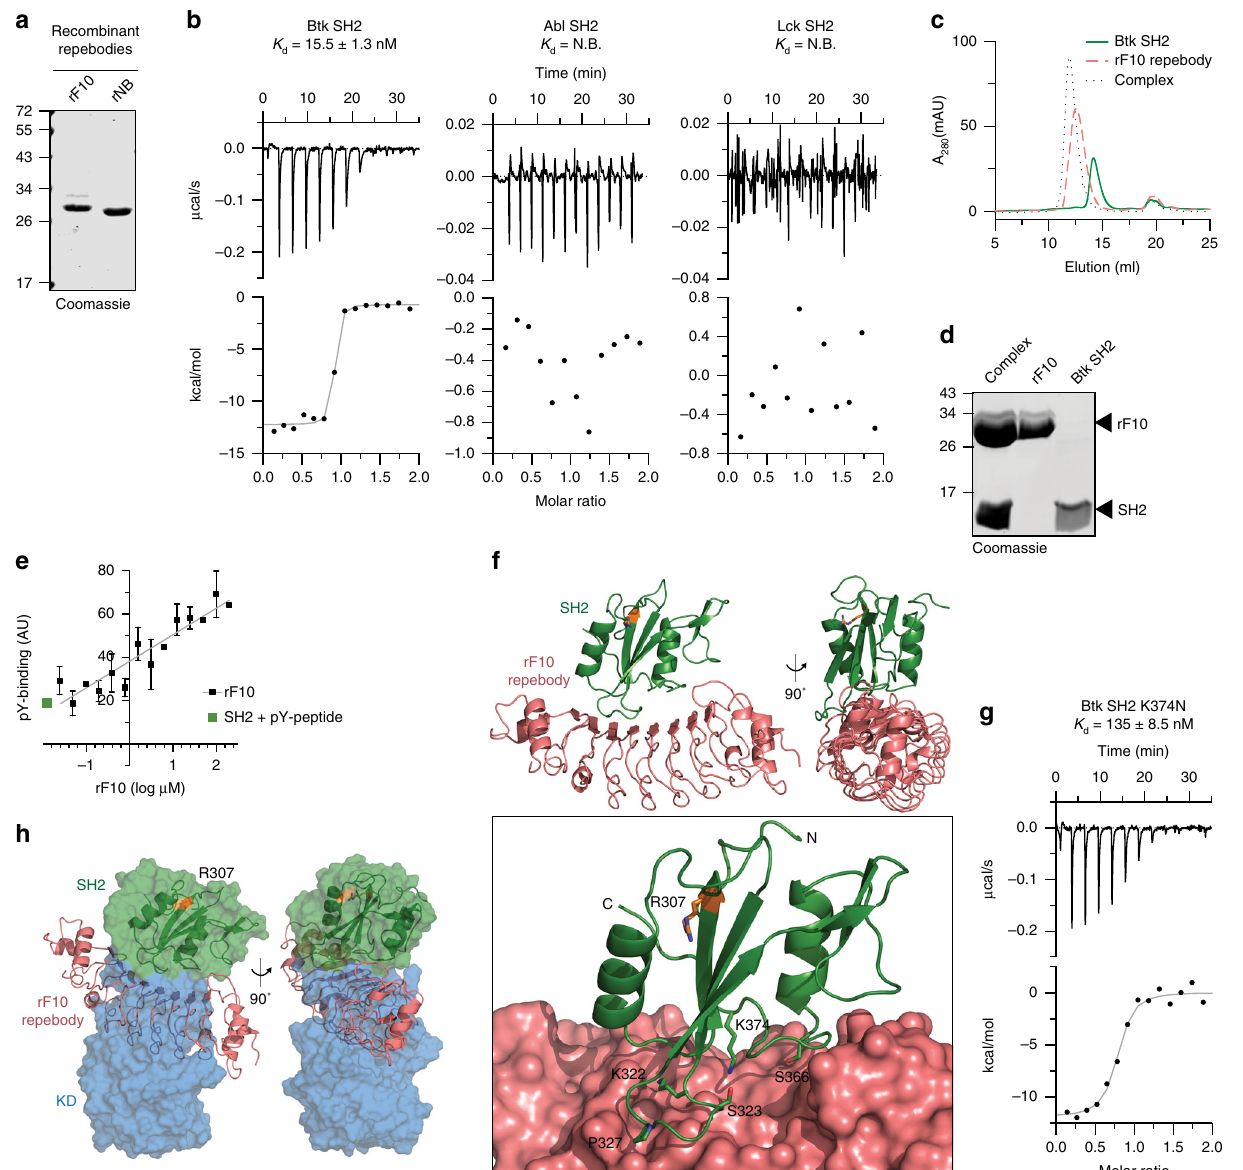
Fig. 5 Development of a high-af fi nity protein binder to the human Btk SH2 domain. a Representative SDS-PAGE analysis of recombinant repebodies rF10 and rNB puri fi ed from E. coli . b Representative ITC measurement of rF10 repebody to the SH2 domains of Btk, Abl and Lck kinases. The top panel show the raw signal and the bottom panel show the integrated calorimetric data of the area of each peak. The continuous line shows the best fi t to the experimental data assuming a 1:1 binding model. Reported K d value for Btk was calculated from three independent measurements. N.B. signi fi es non-binding. c Size- exclusion chromatogram (SEC) analysis of Btk SH2 and rF10 alone, and the SH2-rF10 complex formed by pre-incubation of SH2 and rF10 prior to column injection. d Peaks isolated from the SEC analysis shown in c resolved by SDS-PAGE and stained with Coomassie. e Binding-competition assay using fl uorescently labeled pY-peptide to recombinant Btk SH2 domain in the presence of various concentrations of rF10 repebody. Data are mean ± SD from three technical replicates. f Cartoon representation of the crystal structure of human Btk SH2 (green) in complex with rF10 repebody (salmon), PDB 6HTF. Structural statistics are reported in Supplementary Table 3. The bottom panel shows the rF10 in surface representation, residue R307 (orange) indicates the position of the pY-binding site, and side chains of SH2 residues interacting with rF10 are shown as green sticks. g ITC measurement of rF10 repebody to Btk SH2 K374N performed as in b . The K d value was calculated from two independent measurements. h Superimposition of the active Btk SH2-KD model (surface representation, SH2 in green and KD in blue) with the rF10-SH2 structure (cartoon representation, SH2 in green and rF10 in salmon). Source data are provided as a Source Data fi ibrutinib (Fig. 7b). Also in TMD8 cells, a decrease of the cumu- lative cell numbers were observed (Supplementary Fig. 6b). Cells